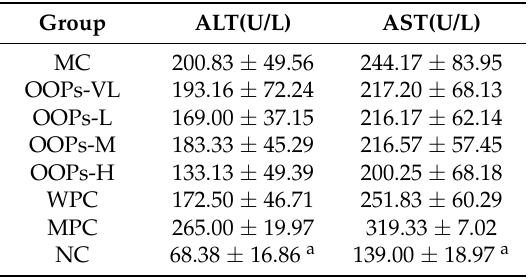
Table 6. Effect of OOPs treatment on the ALT and AST.